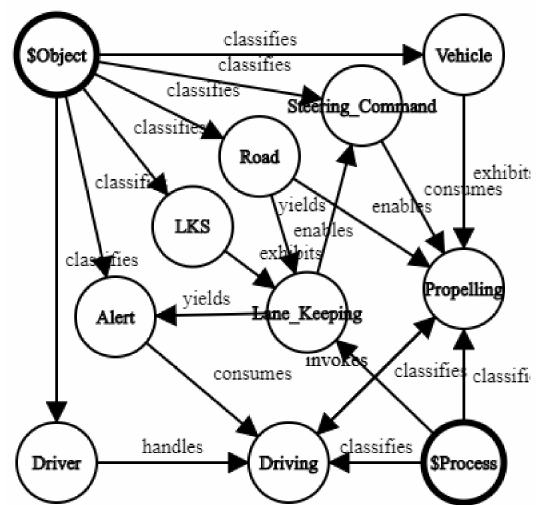
Figure 7. A graph rendition of a subset of the Lane Keeping System (LKS) model in Figure 2. The graph maps the OPM-specifiable terms “$Object”, and “$Process” to Domain entities: Object classifies Vehicle, Driver, and LKS; Process classifies Driving, Propelling, and Lane_Keeping. Domain- internal relations include the mutual invocation between Driving and Propelling, output of Alert and Steering_Command to Driving and Propelling, respectively, and exhibition of Lane_Keeping by LKS. This graph visualizes a subset of the GDS that represents the model. It is clearly difficult to comprehend, and is illustrated for intuition about the possible mapping of a model to a